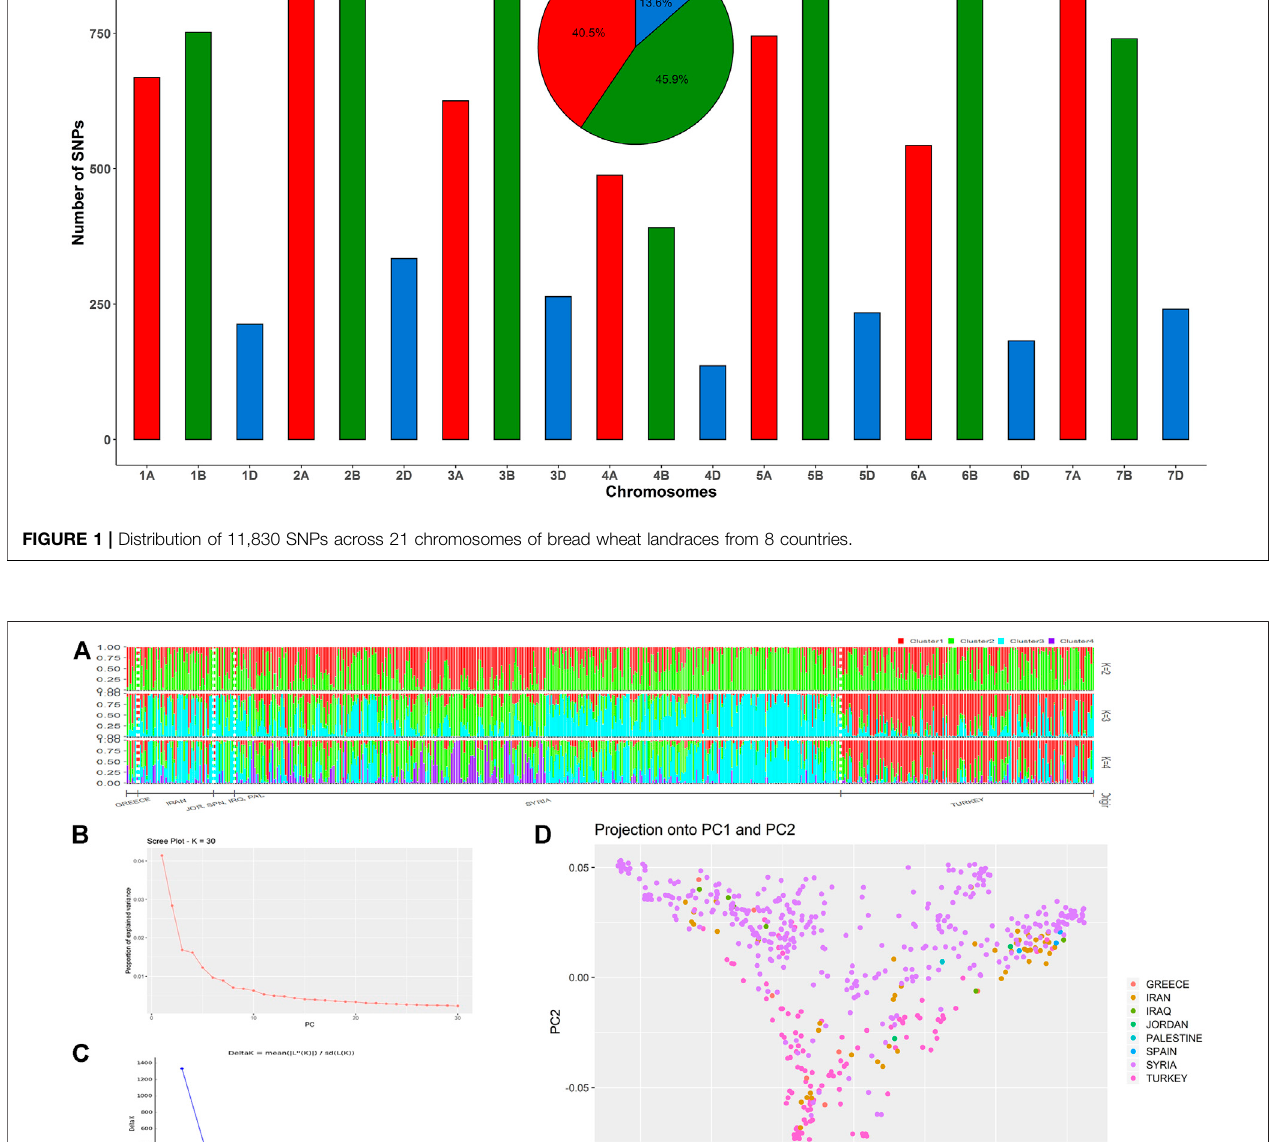
implies 95.8% genetic variance within three subpopulations. The highest genetic variance among the subpopulations (5.9%) was obtained from origin-based AMOVA ( Table 2 ).